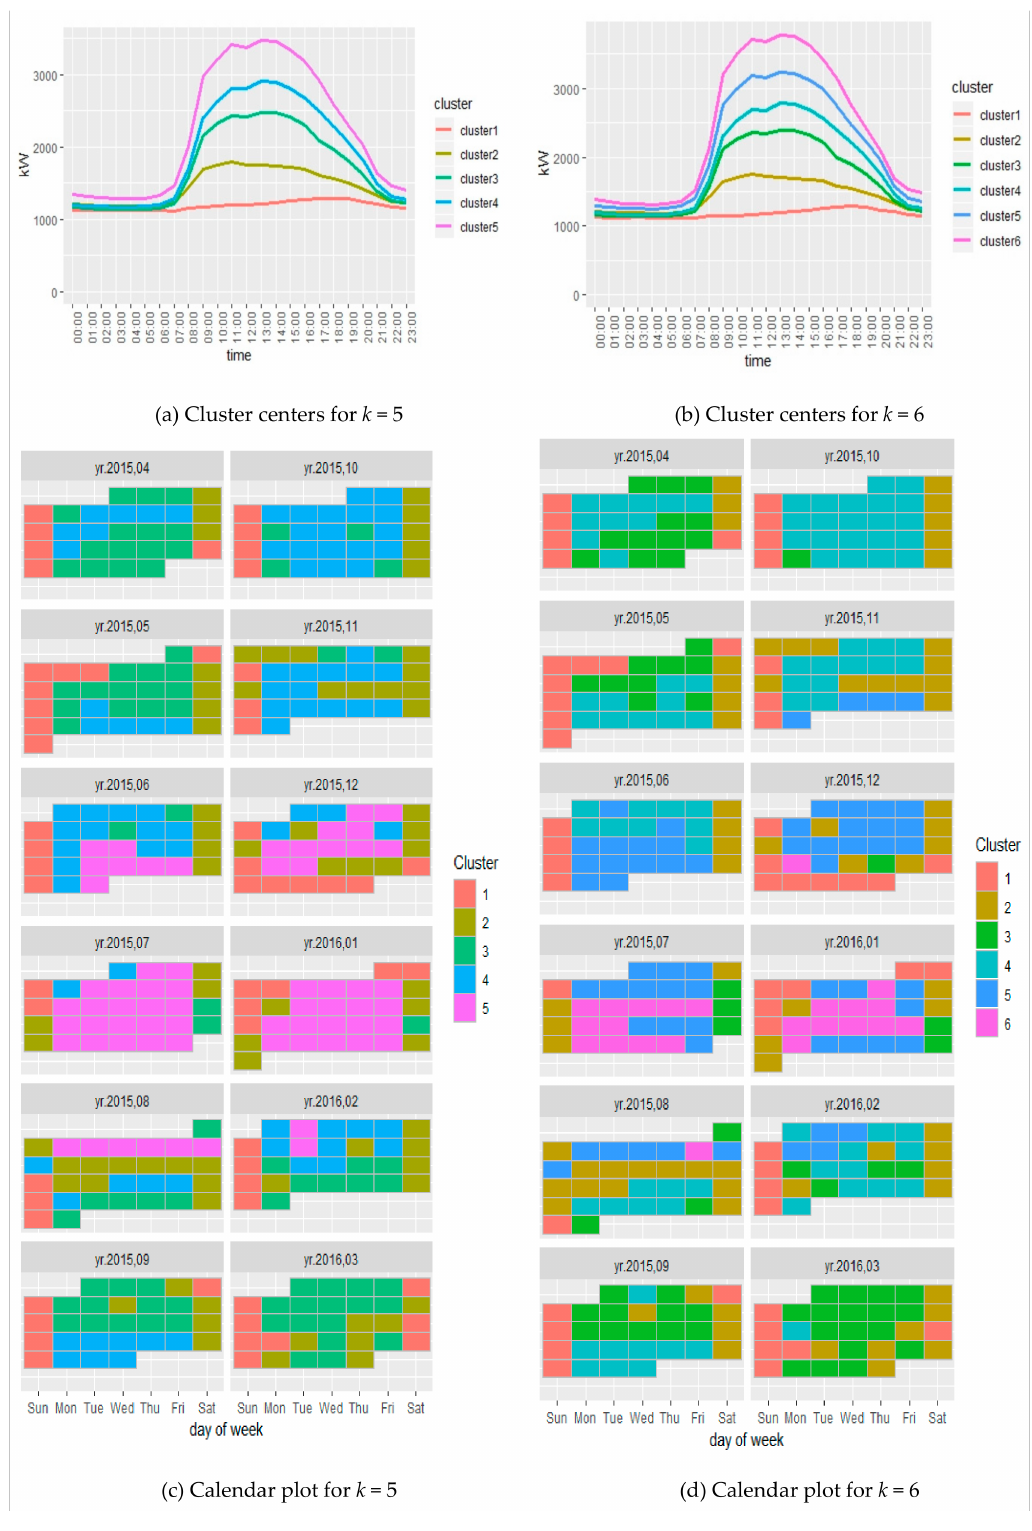
Figure 10. Clustering result for Chubu University. The cluster centers for ( a ) k = 5 and ( b ) k = 6. The calendar plots for ( c ) k = 5 and ( d ) k =